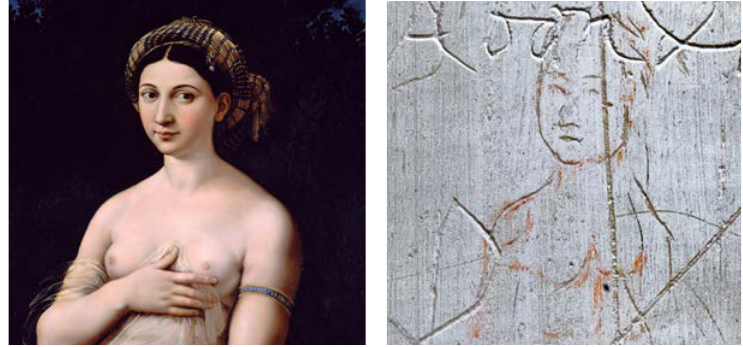
Figure 5 – Left: Raffaello Sanzio, La Fornarina , Inv. n. 2333, detail, Gallerie Nazionali di Arte Antica, Roma. Courtesy of Gallerie Nazionali di Arte Antica (MIBACT) - Bibliotheca Hertziana, Istituto Max Planck per la Storia dell’Arte/Enrico Fontolan. Further reproduction or duplication by any means is prohibited. Right: a drawing of a woman, located below the following writing ‘Franceschina inamorata de lo mco compagno suo’ i.e. ‘Franceschina in love with Marco her companion’ and therefore I have called the portrayed woman ‘Franceschina’. It must be added that between the writing and the drawing there is some space, occupied by another, later piece of writing about a big snow fall on 8 May 1682 (partially overlapping the head of the alleged Franceschina)